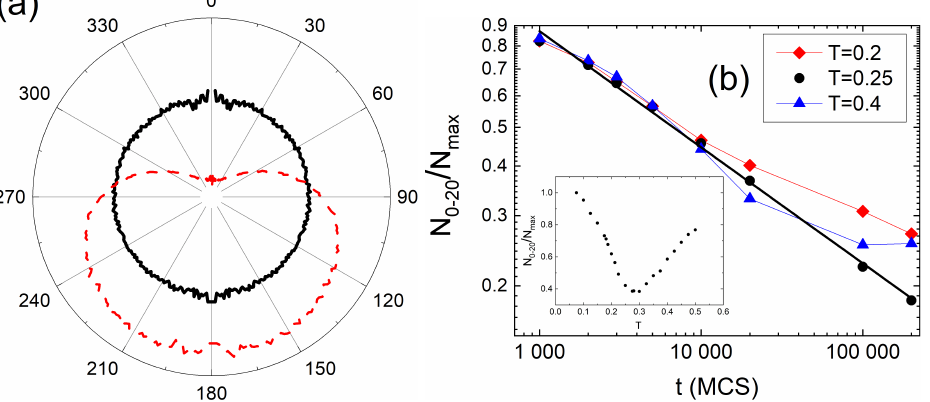
Figure 25. ( a ) Polar plot of angular distribution ρ ( θ ) / sin θ for t = 0 (solid black line) and t = 2 × 10 5 MCS (dashed red line). ( b ) Double logarithmic plot of N 0 − 20 ( t ) / N max for T = 0.2,0.25 and 0.4. Inset: temperature dependence of normalized parameter N 0 − 20 / N max for t = 2 × 10 5 MCS. See text for more details. Based on